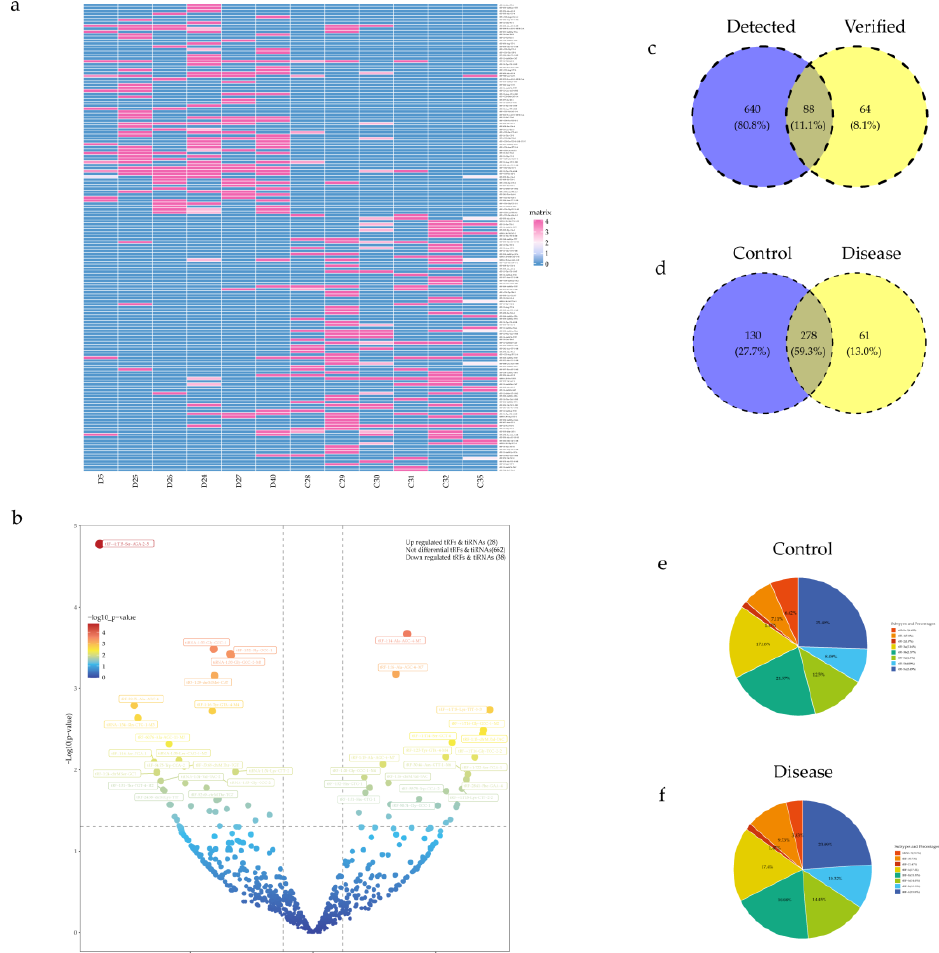
Figure 2. Differential expression of tRFs/tiRNAs between pregnant women with abnormal fetal heart and normal fetal hearts. ( a ) Heatmaps of aberrantly expressed tRFs/tiRNAs in pregnant women with fetal heart defects and normal fetal hearts. ( b ) Volcanic diagrams of aberrantly ex- pressed tRFs/tiRNAs in pregnant women with fetal heart defects and normal fetal hearts, 66 tRFs/tiRNAs were reported to be dysregulated in group disease compared with group control, of which 28 were up-regulated and 38 were down-regulated. ( c ) Out of a total of 728 differentially regulated tRFs/tiRNAs detected, 88 could be found in tRFdb, and the rest were unknown. ( d ) 61 tRFs/tiRNAs specifically expressed in group disease and 130 tRFs/tiRNAs specifically expressed in group control. ( e , f ) The percentage of expression of each isoform of tRFs/tiRNAs in the two groups of samples. Subsequently, we looked for up- and down-regulated tRFs/tiRNAs in the sequencing results in MINTBASE, and the results showed that five up-regulated tRFs/tiRNAs and 13 down-regulated tRFs/tiRNAs could be looked up in MINTBASE (Table S1). We verified the expression levels of these tRFs/tiRNAs in the peripheral serum of pregnant women (12 disease, 12 control) by qRT-PCR. The qRT-PCR results showed that in the disease group, tRF-58:74-Gly-GCC-1 was up-regulated and tiRNA-1:35-Leu-CAG-1-M2 was down-regulated. We were unable to detect statistically significant differences in the ex- pression of other tRFs/tiRNAs (Figure 3c). Then, we proceeded to expand the sample size (35 disease, 48 control) for further validation of tRF-58:74-Gly-GCC-1 and tiRNA-1:35- Leu-CAG-1-M2. The qRT-PCR results showed that tRF-58:74-Gly-GCC-1 was significantly